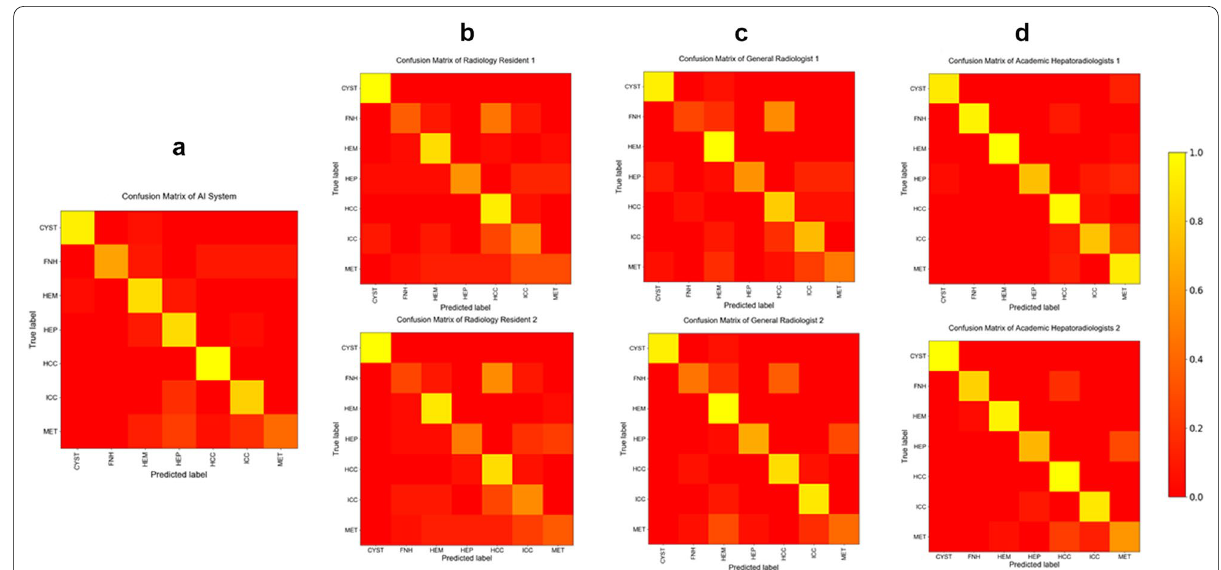
Fig. 4 Confusion matrices showing the distribution of the diagnostic predictions of seven categories of common FLLs for the ( a ) model, ( b ) radiology residents, ( c ) general radiologists and ( d ) academic radiologists. True disease labels are shown along the x ‑axis, and the predictions are shown along the y ‑axis. Predictions the same as the true disease labels resulted in yellow squares along the diagonal from top left to bottom right. Each category of radiologists made errors in divergent diagnoses, but fewer errors occurred with increasing radiologist specialisation